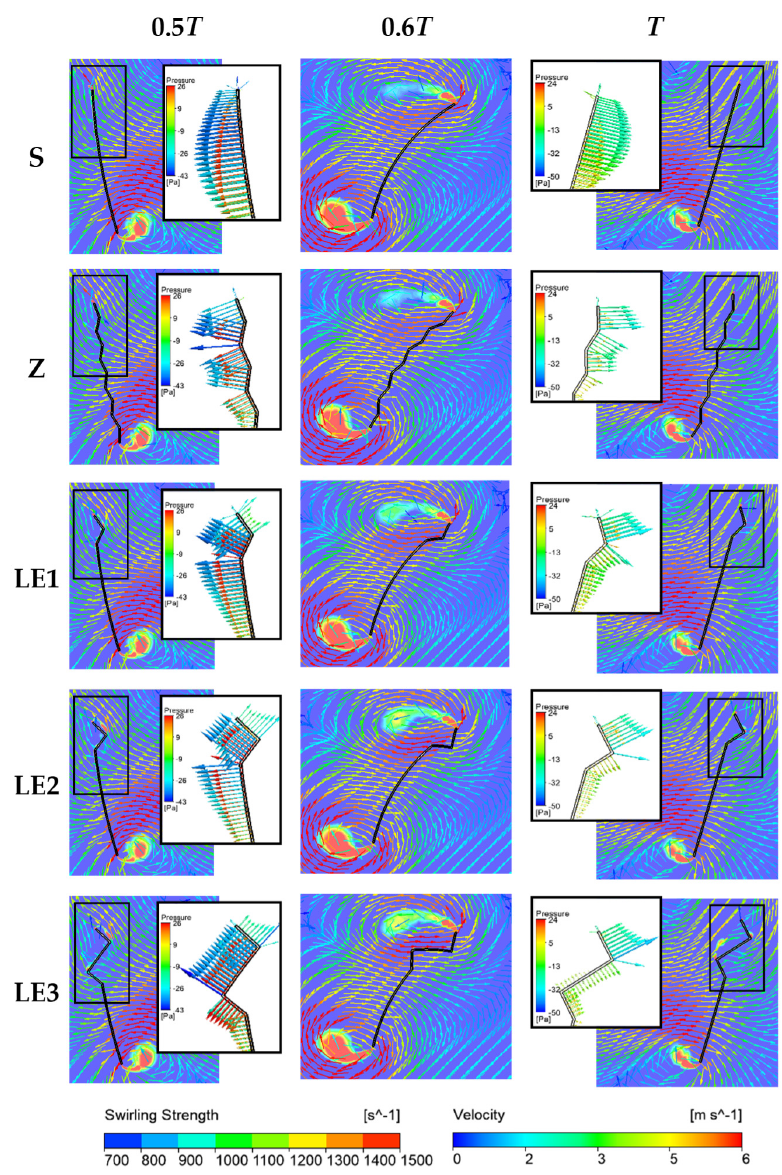
Figure 9: Flow fields, swirling strength, and pressure acting on the surfaces of the five wings at r =0.375 R .